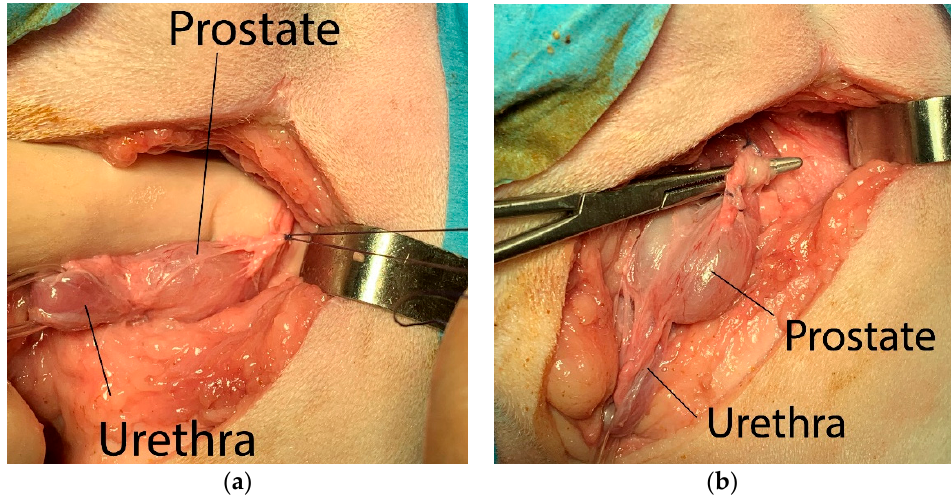
Figure 2. Surgery steps: ( a ) ligatures of the the neuro-vascular bundles located dorso-laterally to the prostate; ( b ) the vas deferens were identified and ligated before the gland was tractioned caudally.